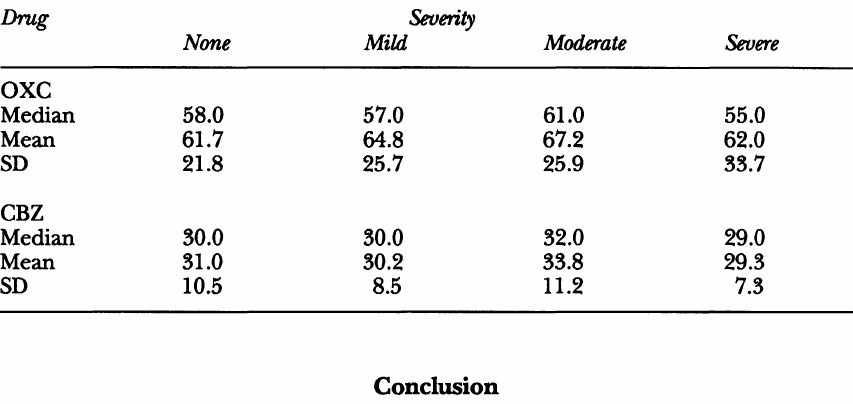
TABLE 3. Correlation between severity of sidHffects and serum concentrations of oxcarbazepine (OXe) and carbamazepine (CBZ)(llmolll) Drug Severity None Mild